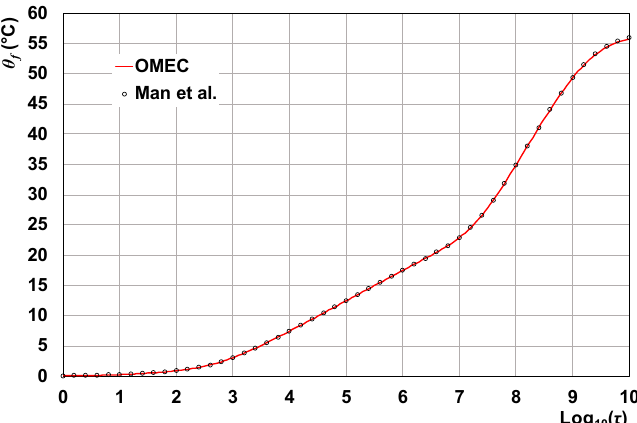
Figure 12. Isoflux fluid-to-ground thermal response of a 2 × 2 borefield versus log 10 ( τ ), simulation of OMEC and analytical solution by Man et al. [42].